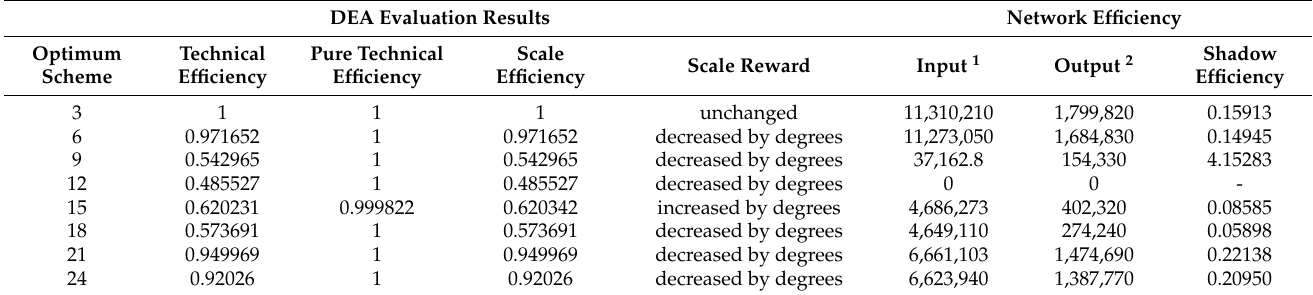
Table 11. DEA evaluation results of each program for a 10% decrease in passenger flow